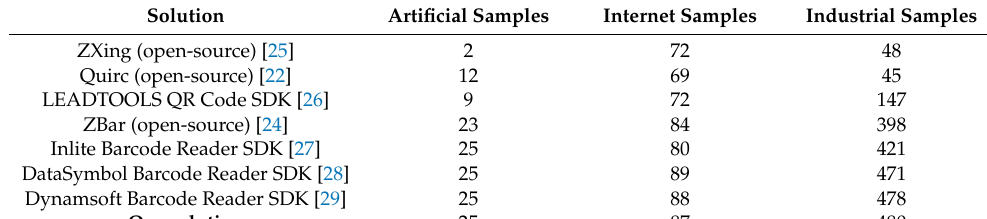
Figure 16. Testing samples: ( a ) artificial, ( b ) Internet, ( c ) industrial.